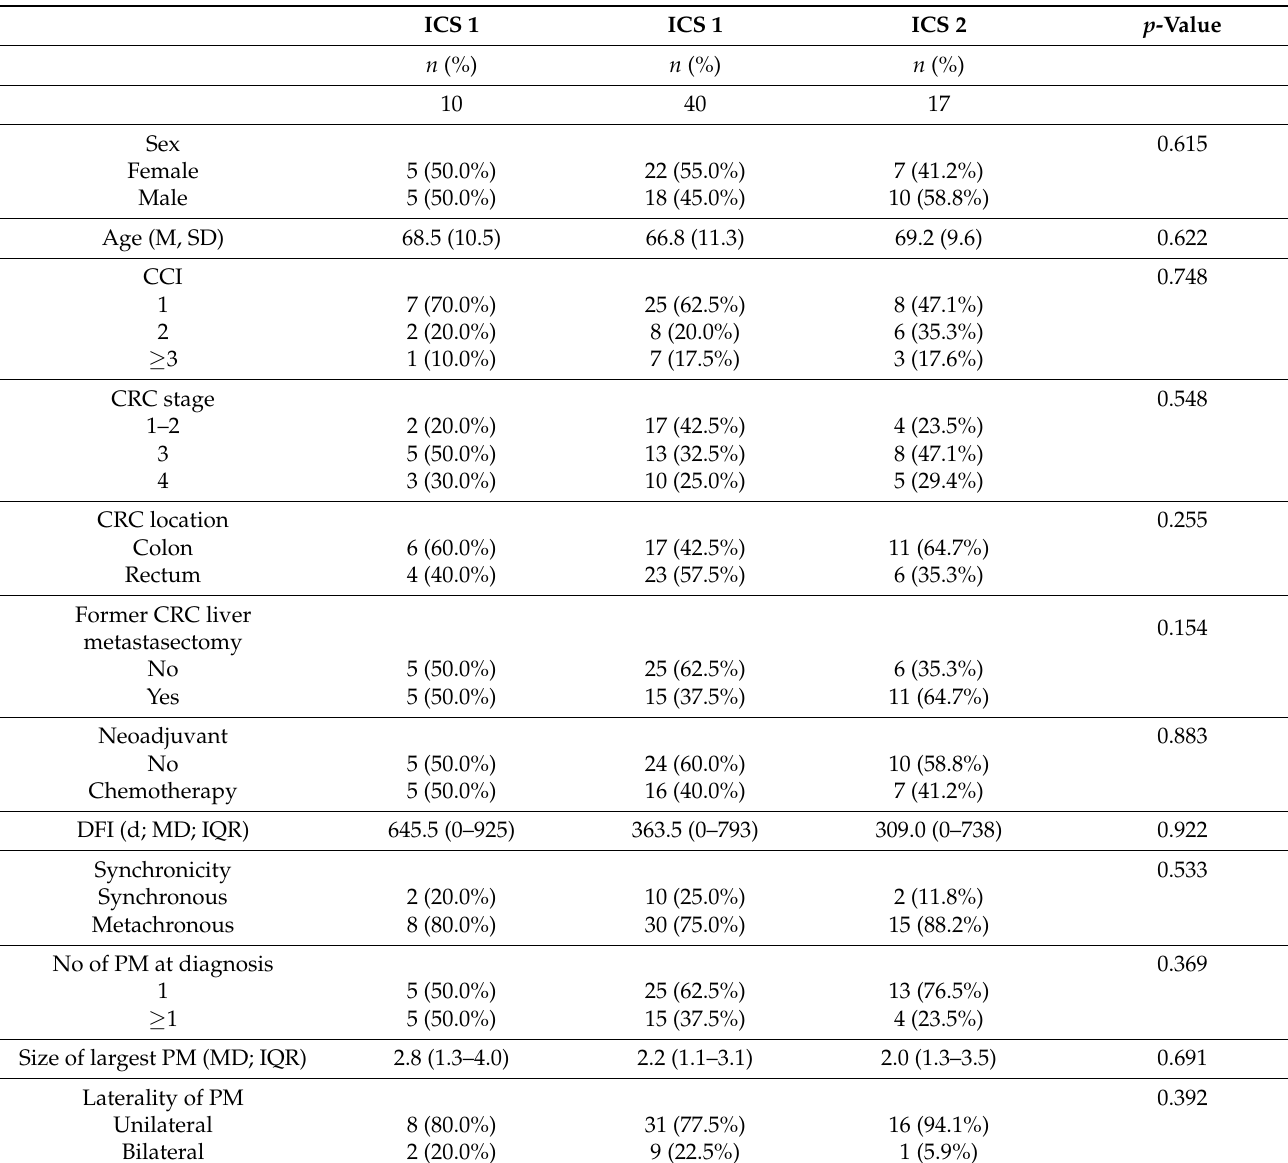
Table 1. Baseline characteristics of pulmonary metastasectomy patients ( n = 67) according to immune cell score from pulmonary